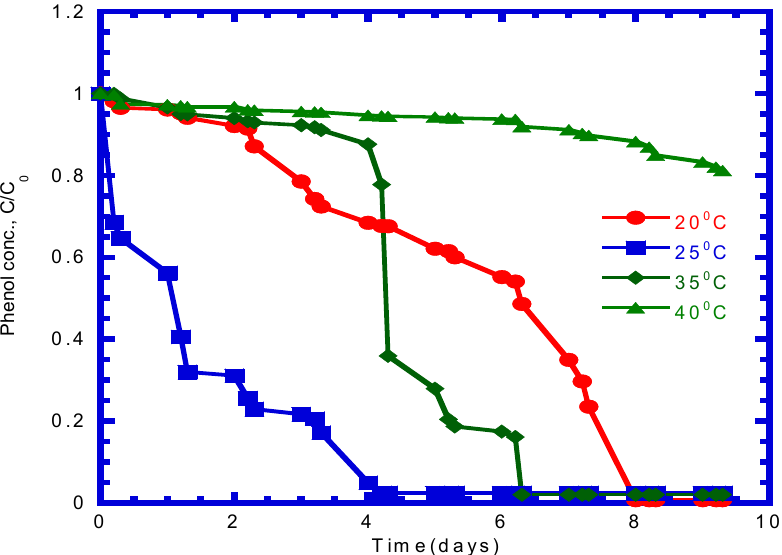
Figure 6. Influence of temperature on phenol utilization by immobilized cells with nano-Fe 3 O 4 in the batch reactor. Initial phenol concentration was 336 mg/L.